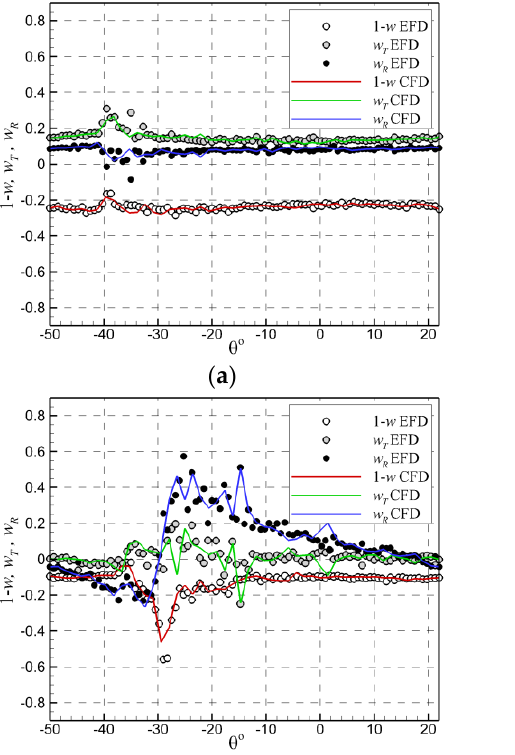
Figure 14. Comparison between the normalized axial velocities measured [44] and computed at x / D =0.1. ( a ): measured values; ( b ): computed values.